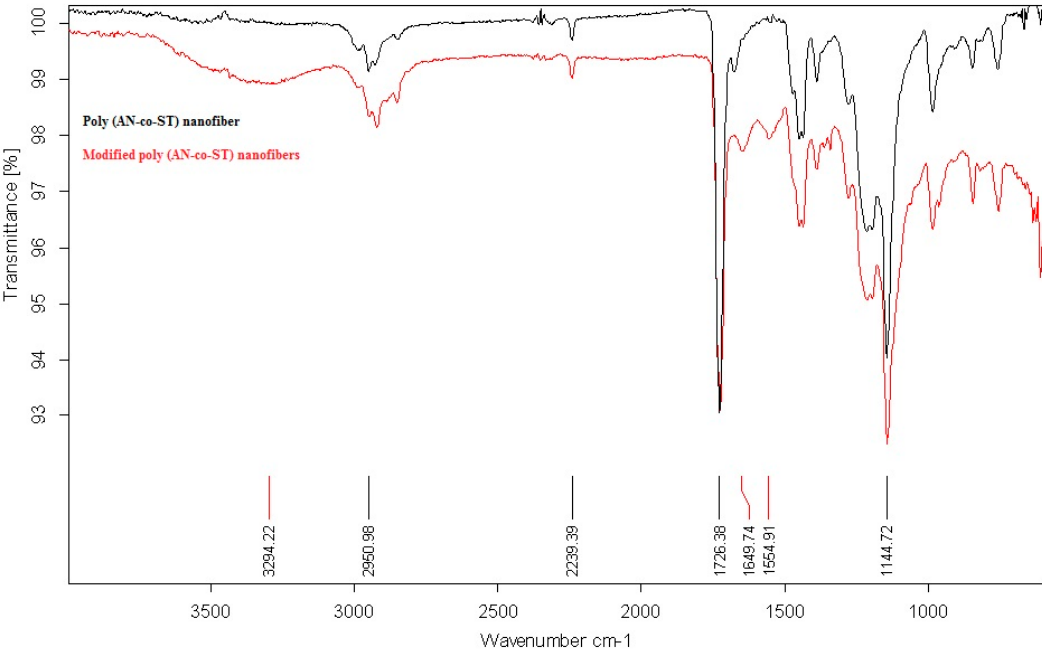
Figure 2. FT-IR spectra of poly(AN- co -ST) nanofiber and modified poly(AN- co -ST) nanofibers.